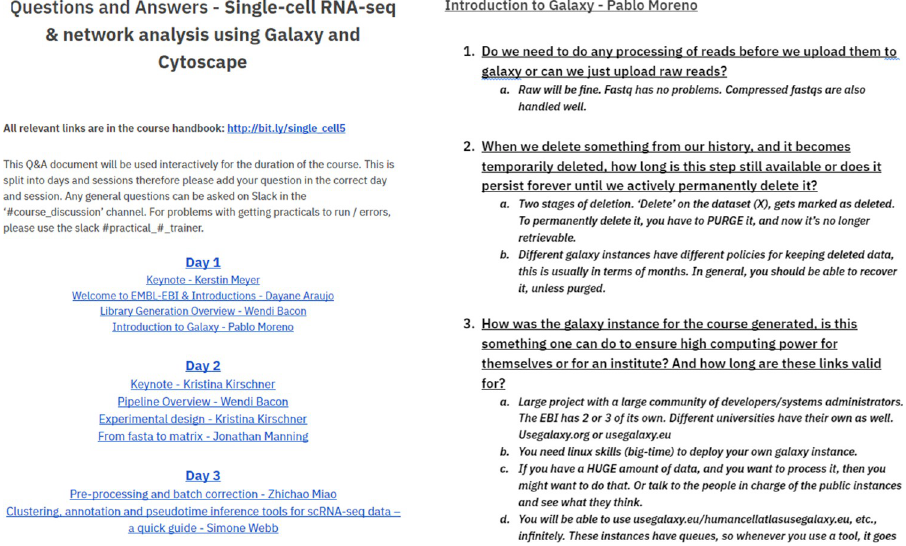
Fig 2. Question and answer document from the Single-cell RNA-seq & network analysis using Galaxy and Cytoscape course 2021